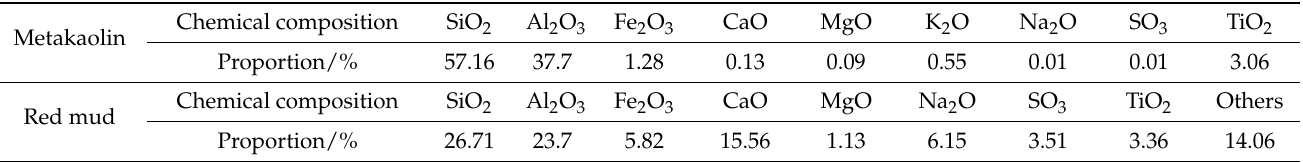
Table 3. Chemical composition of metakaolin and red mud.